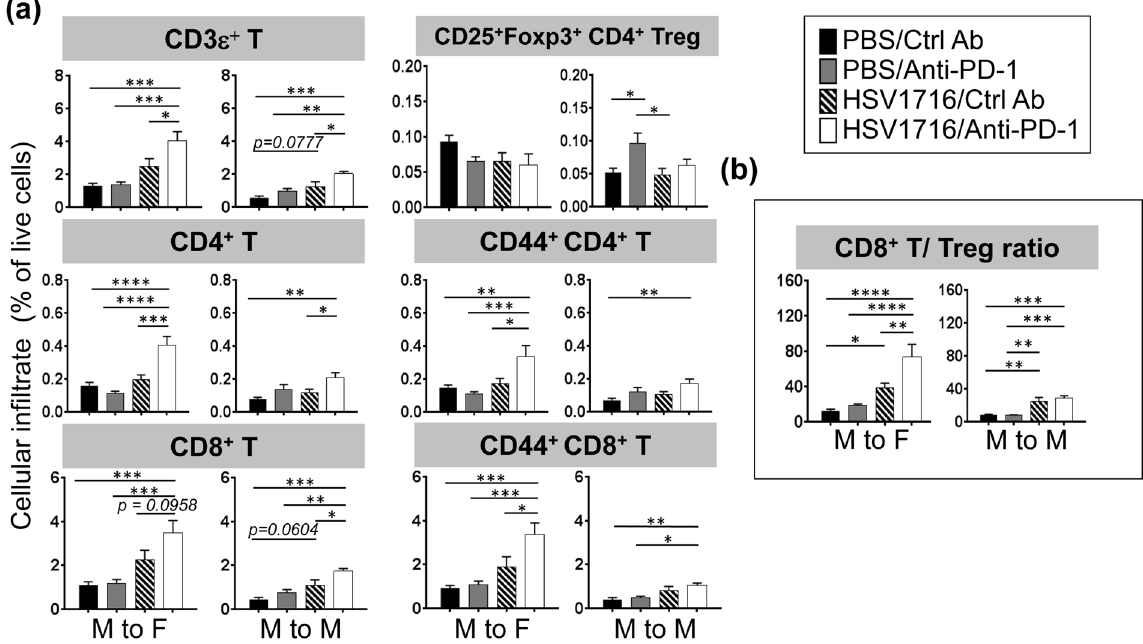
Figure 7. Combination therapy increases CD4 + and CD8 + T cells in tumor in proportion to immunogenicity. Female (M to F) or male (M to M) M3-9-M tumor-bearing mice received three doses of intratumoral HSV1716 injection followed by intraperitoneal injection of anti-PD-1 or control antibody as shown in Fig. 4a. ( a ) Immune cell infiltrates in tumors were evaluated by flow cytometry analyses 72 hours after last dose of HSV1716 injection. PD-1 blockade alone had little to no impact on overall T cell numbers, but enhanced HSV1716- induced T cell recruitment, particularly in the more immunogenic female M3-9-M model. ( b ) Combination therapy results in higher CD8 + T cell to Treg ratios in female M3-9-M model, which is associated with improved therapeutic outcomes. Data show mean and SEM (n = 5~8 per treatment group). Statistical analysis was performed by a one-way ANOVA with Tukey-adjusted post hoc tests ( * p < 0.05, ** p < 0.01, *** p < 0.001 and **** p <